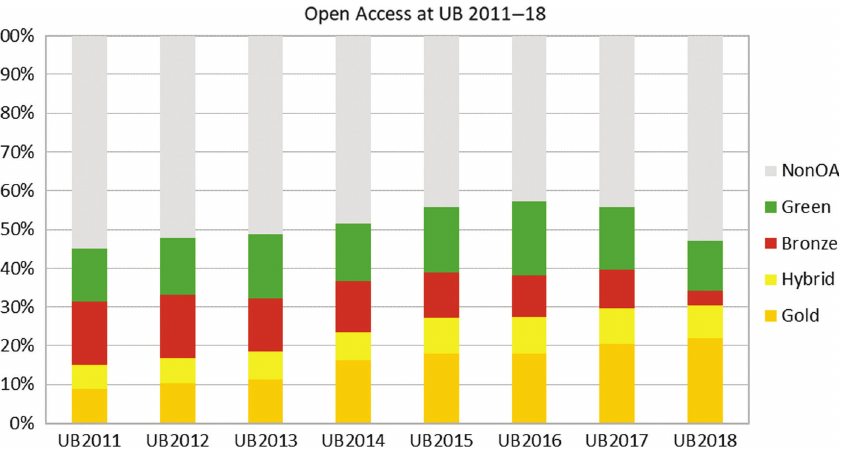
Fig. 3: Open Access situation at UB 2011–2018. Analysis of the research publications from 2011 to 2018. Results obtained in March 2019.